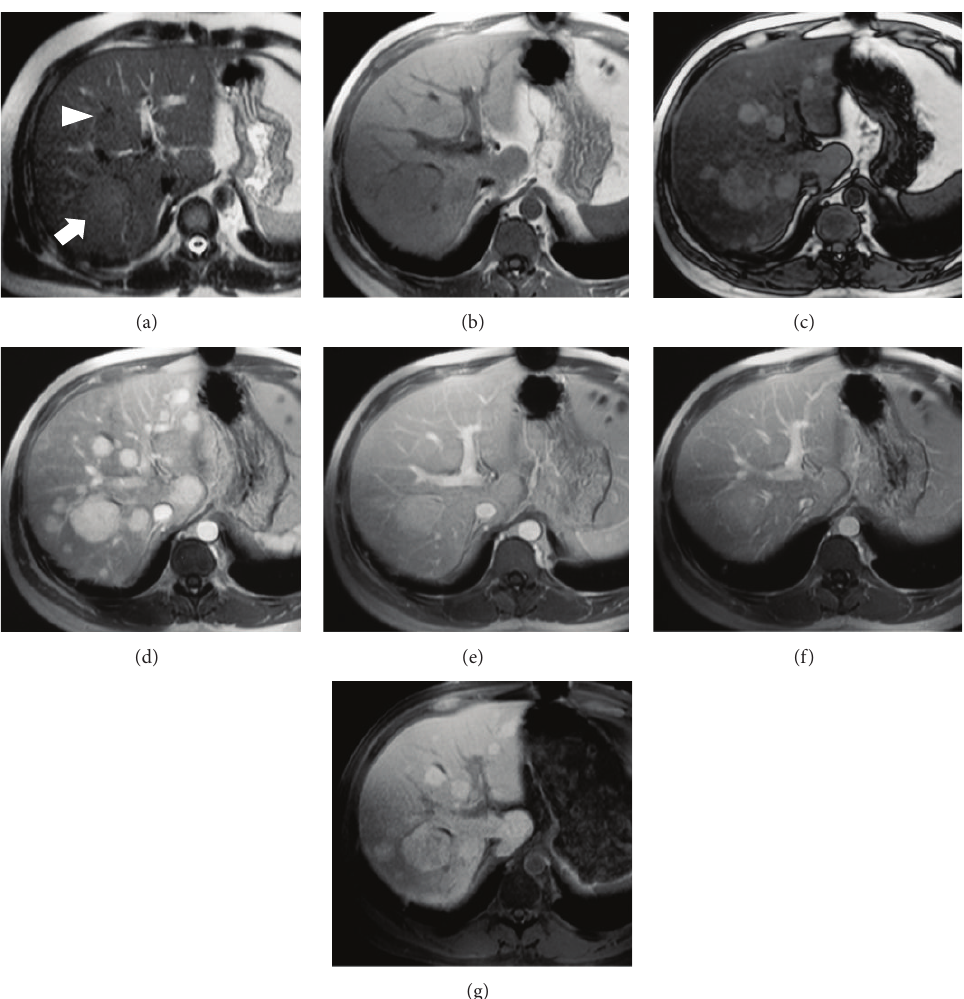
Figure 8: Large regenerative hyperplasia. (a) Axial T2w image. In S VII slightly hyperintense nodule (arrow); in SIV moderate hypointense lesion (arrowhead). (b-c) T1w in- and out-phased images. Due to significant steatosis of hepatic parenchyma after chemotherapy, many other hypointense lesions appear in out-phased sequence. (d–f) In dynamic evaluation after Gd-BOPTA administration the nodules appear significantly hypervascular in arterial phase (d) and tend to be isointense in portal and equilibrium phases. (g) Hepatobiliary phase image after 1 hour. Nodules are